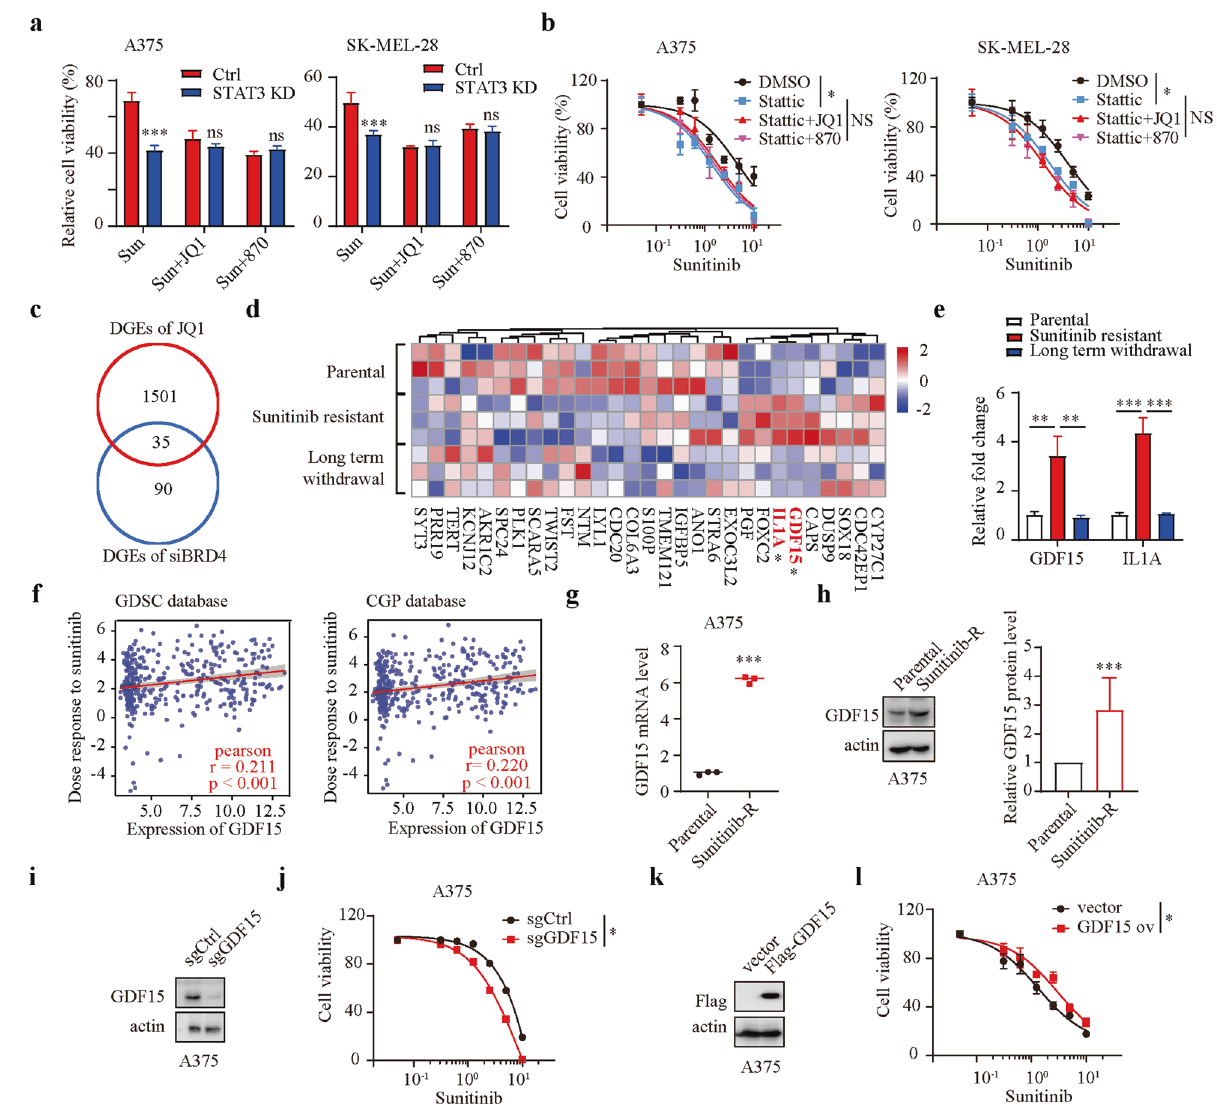
Fig. 5 BET inhibitors regulate sunitinib sensitivity by inhibiting STAT3 activity and GDF15 expression. a The viability of shCtrl and shSTAT3 melanoma cells was evaluated after treatment with sunitinib (1 μ M) alone or in combination with JQ1 (1 μ M)/NHWD-870 (10 nM). b Dose response of sunitinib-induced death in A375 and SK-MEL-28 cells in the presence of DMSO, 1 μ M stattic, or 1 μ M stattic + JQ1 (1 μ M)/NHWD- 870 (10 nM). c Venn diagram of the overlapping genes in the indicated groups. d Heatmap of the overlapping genes in parental cells, sunitinib-resistant cells, and cells with long-term withdrawal of sunitinib from the GSE122821 dataset. If the mRNA level of a gene was markedly increased in sunitinib-resistant cells and comparable to that in parental cells after long-term withdrawal of sunitinib, the gene is marked with an asterisk and shown in red. e Fold changes in GDF15 and IL1A expression in parental cells, sunitinib-resistant cells, and cells with long-term withdrawal of sunitinib from the GSE122821 dataset. f Association between the expression of GDF15 and the logIC50 of sunitinib in Genomics of Drug Sensitivity in Cancer and Cancer Genome Project datasets. g GDF15 mRNA levels in parental and sunitinib- resistant A375 cells. h Western blotting and qualitative analysis of GDF15 expression in parental and sunitinib-resistant A375 cells. i GDF15 protein levels were quanti fi ed by western blotting in control (sgCtrl) and GDF15-de fi cient (sgGDF15) cells. j Dose response of sunitinib- induced death in sgCtrl and sgGDF15 A375 cells over a 24 h period. k GDF15 protein levels were quanti fi ed by western blotting in control (Flag vector) and GDF15 overexpression (Flag-GDF15) cells. l Dose response of sunitinib-induced death in vector and GDF15-overexpressing A375 cells over a 24 h period. Two-way ANOVA was performed in ( a ). Nonlinear regression was applied in ( b , j and l ). One-way ANOVA